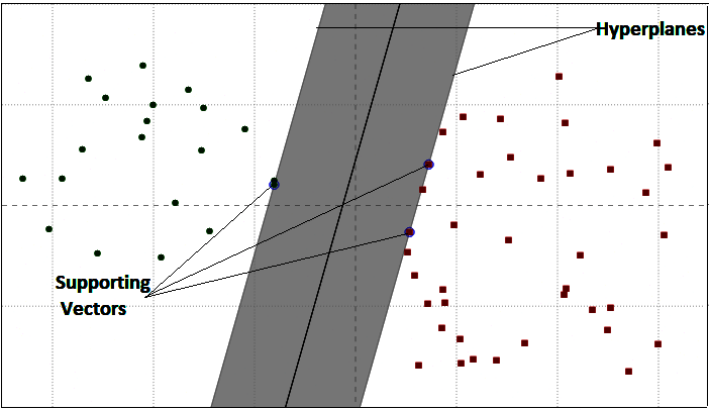
Figure 5. The depiction of the SVM with the linear kernel, supporting vectors, and hyperplanes.